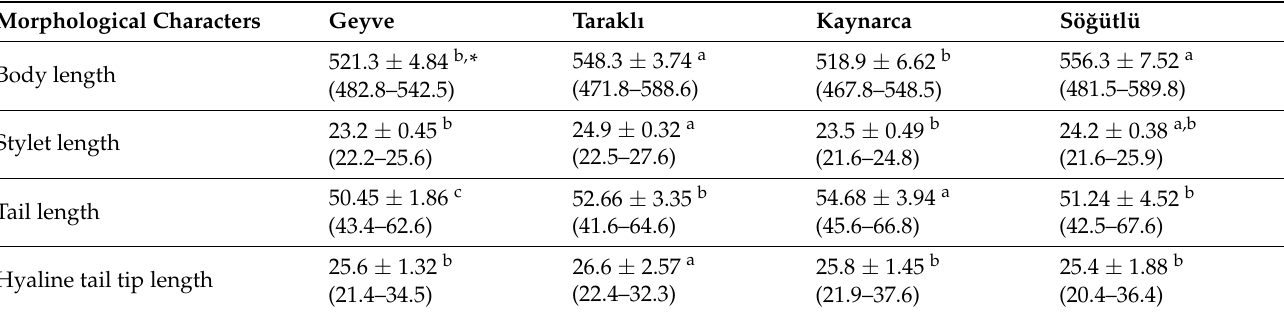
Table 6. Morphological and morphometrical characteristics of second juveniles and cysts of Heterodera filipjevi populations ( n = 10); measurement unit in µ